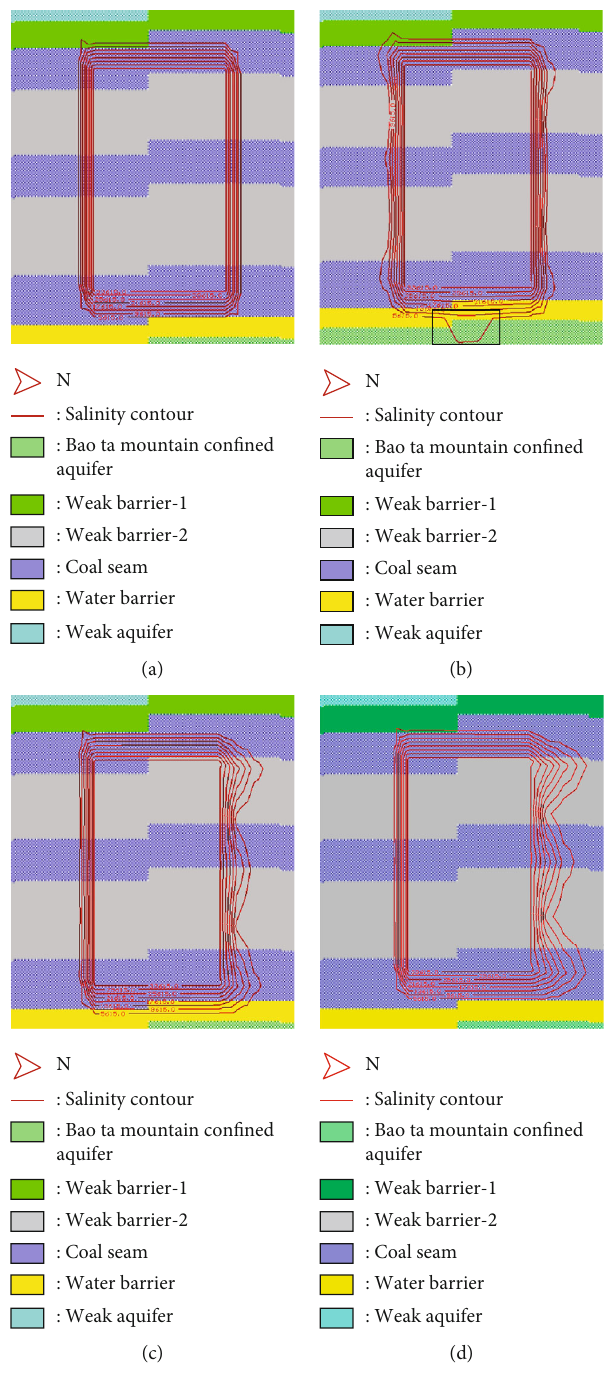
Figure 11: The migration of concentrated brine to the north side under di ff erent groundwater head di ff erences after long-term penetration for 70 years (the model is stretched 20 times the actual vertical direction, (a) is the initial state, (b) is 10 meters, (c) is 50 meters, and (d) is 100